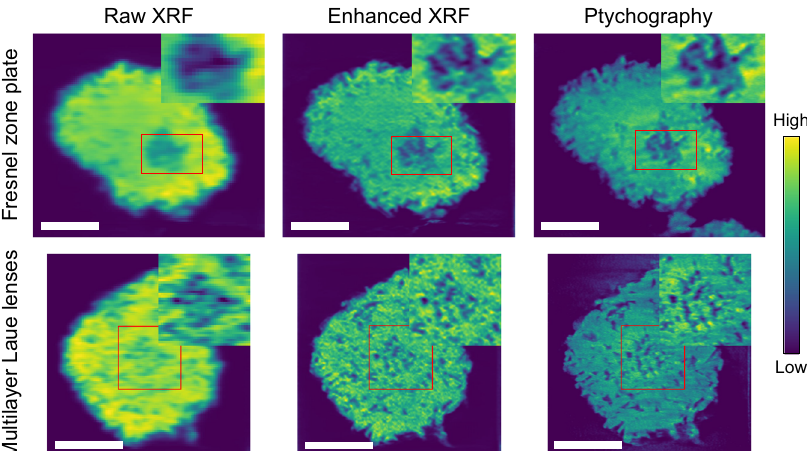
Fig. 4 Comparison of experimental low-resolution XRF images and resolution-enhanced XRF images. In each image, the central slices of the 3D reconstructed structures of NMC particles are displayed. The experimental datasets were collected using different scanning X-ray probes, respectively. The left column shows the central slice of the raw XRF tomography reconstruction for the Nickel signal. The middle column shows the corresponding central slice of the 3D tomography reconstruction using the spatial resolution-enhanced Ni XRF results from the RDN model. The right column shows the central slice of the phase-contrast image from the ptychographic tomography reconstruction. Here, the insets indicate the area marked by the red boxes and all the scale bars are 2 μ